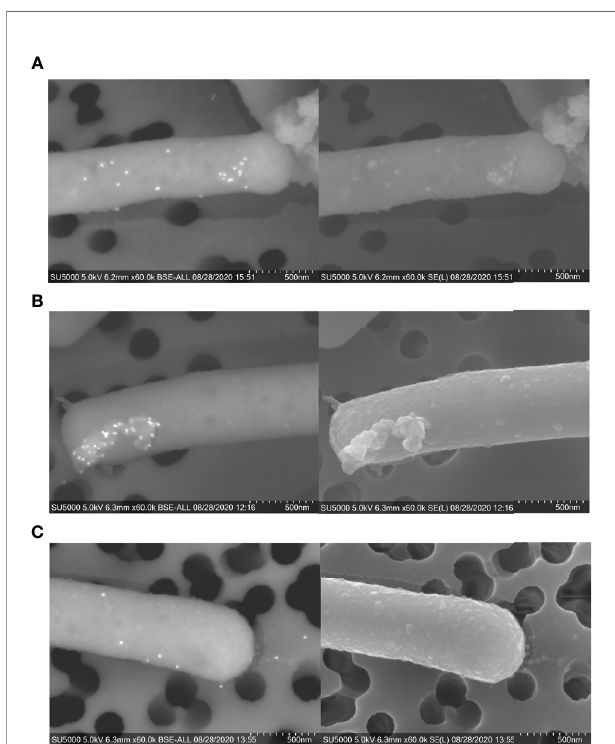
FIGURE 6 | Immunogold staining of L. johnsonii N6.2 whole cells. SEM [BSE (left) and SE (right)] images of immunogold staining of